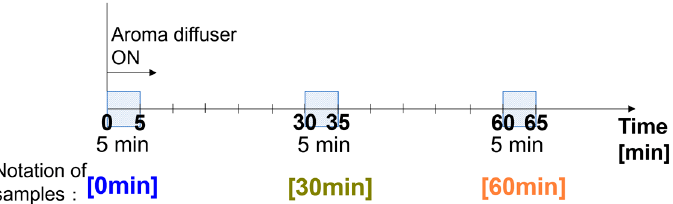
Figure 4. Schedule of collecting air, including diffused essential oils and effective components by TD tubes.